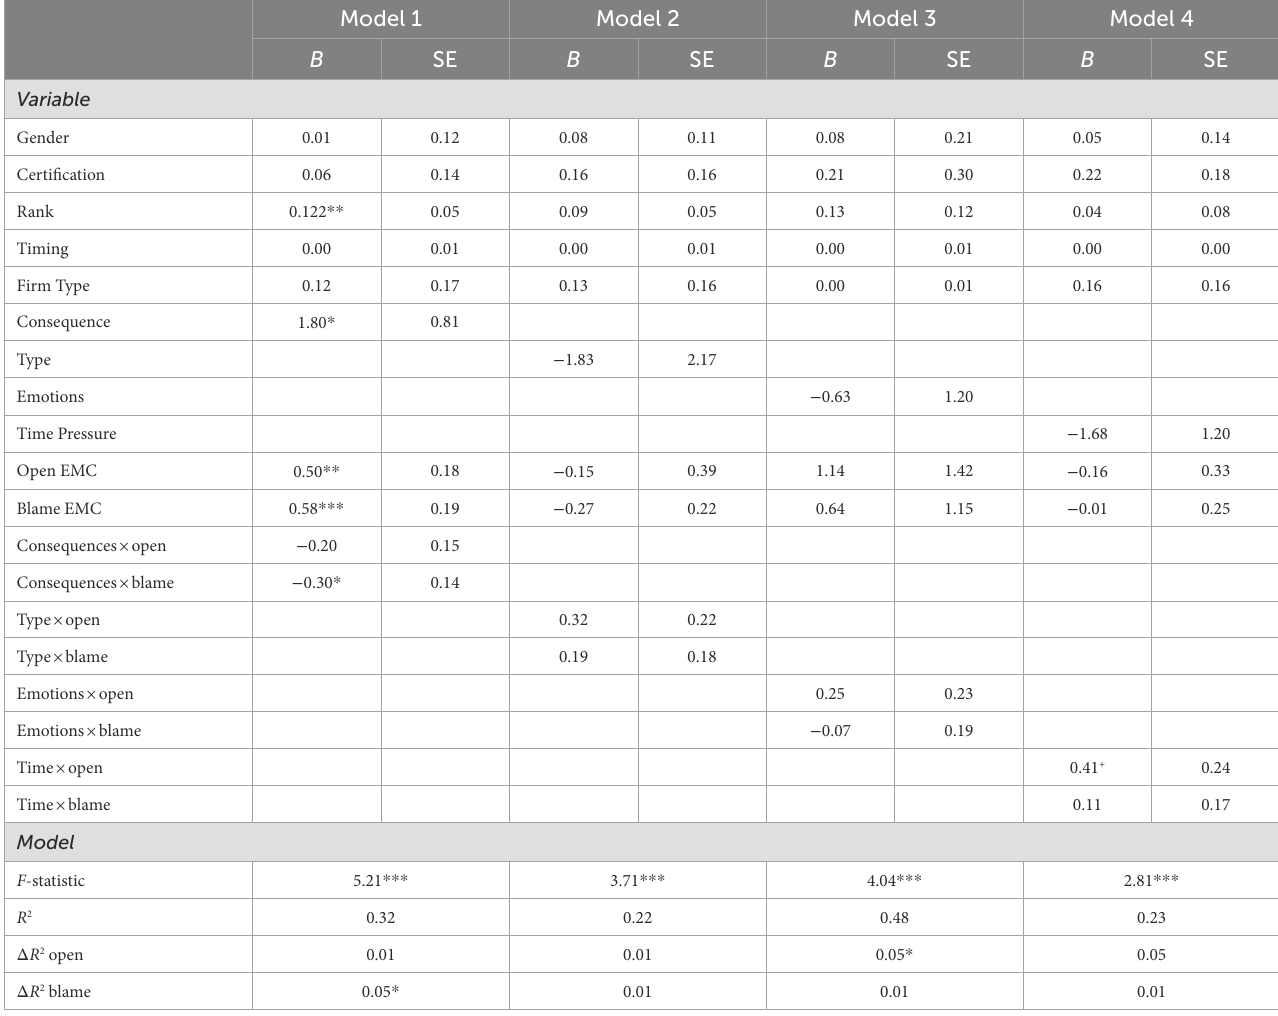
TABLE 2 OLS Moderation